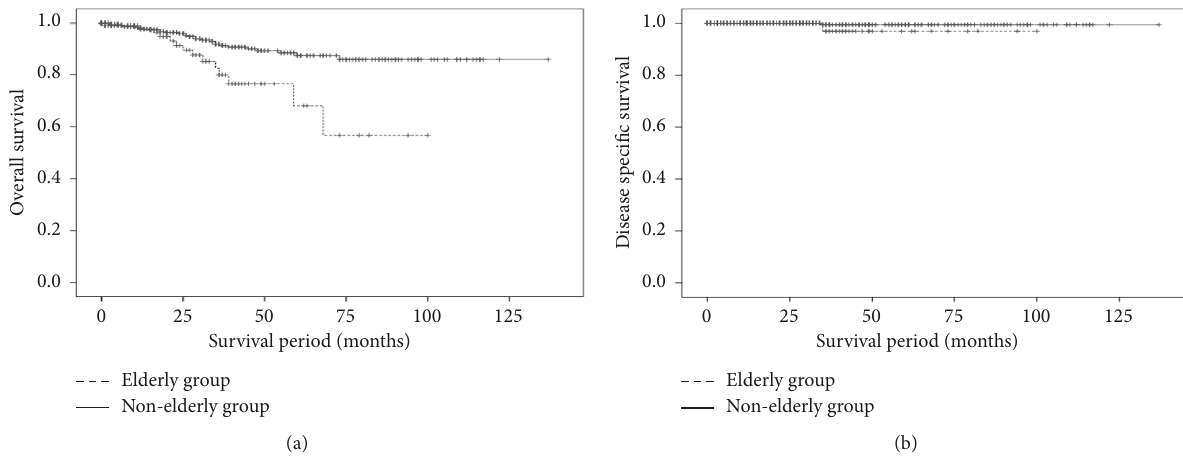
Figure 1: Comparison of overall survival (OS) and disease-specific survival (DSS) between the elderly and nonelderly groups. (a) Comparison of OS between the elderly and nonelderly groups. The mean survival time periods were 75.8 ± 5.9 and 122.8 ± 2.6months in the elderly and nonelderly groups, respectively ( P < 0 . 05, log-rank test). (b) Comparison of DSS between the elderly and nonelderly groups. The mean survival time periods were 98.0 ± 2.0 and 136.4 ± 0.6months in the elderly and nonelderly groups, respectively (not significant, log- rank test). Table 5: Univariate and multivariate analyses of the risk factors of death. Univariate